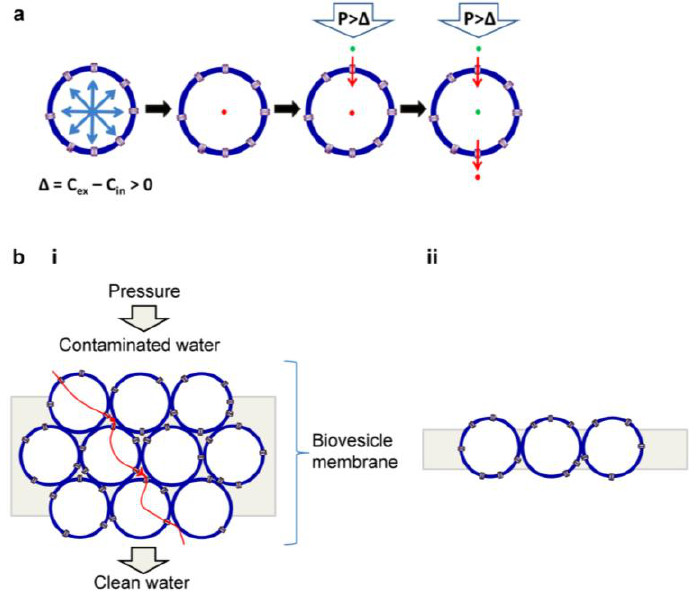
purification membrane using aquaporin-incorporated vesicles. ( a ) Principle of reverse osmosis in a single vesicle and ( b ) schematic diagram of a membrane made with ( i ) multi-layer stacking and ( ii ) single-layer stacking of